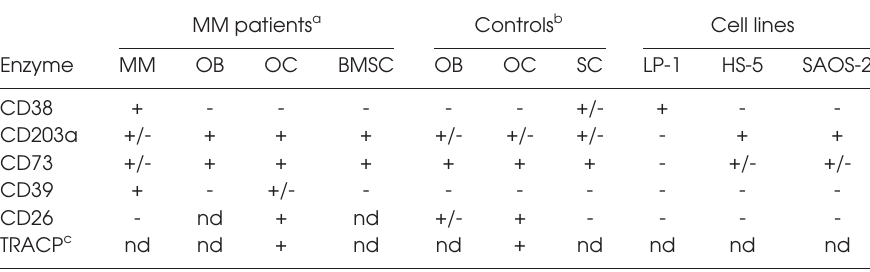
table 3. Phenotype of myeloma cells and cell lines, osteoclasts, osteoblasts and stromal cells.